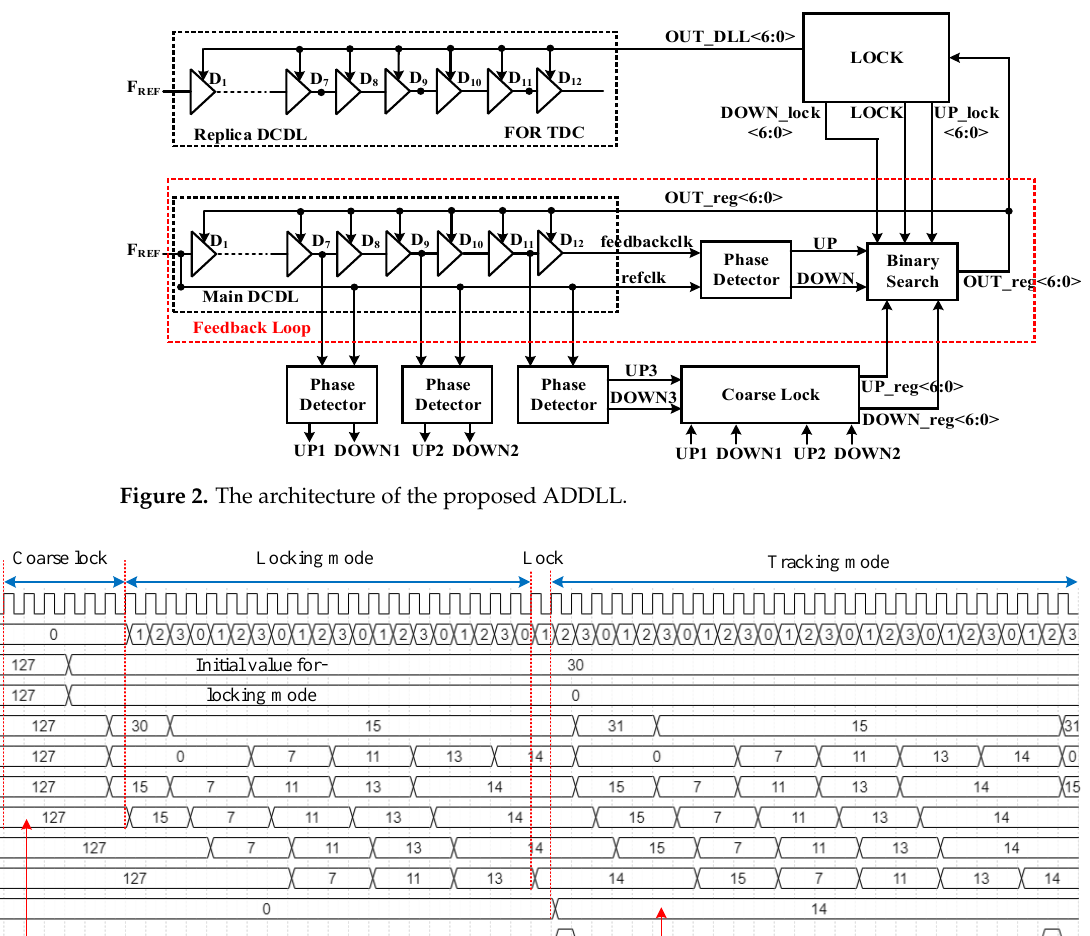
Figure 2. The architecture of the proposed ADDLL.